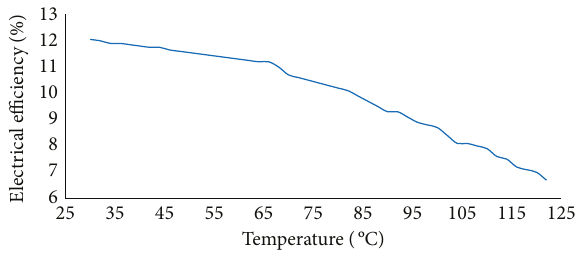
Figure 5: Electrical e ffi ciency-temperature of the noncooling